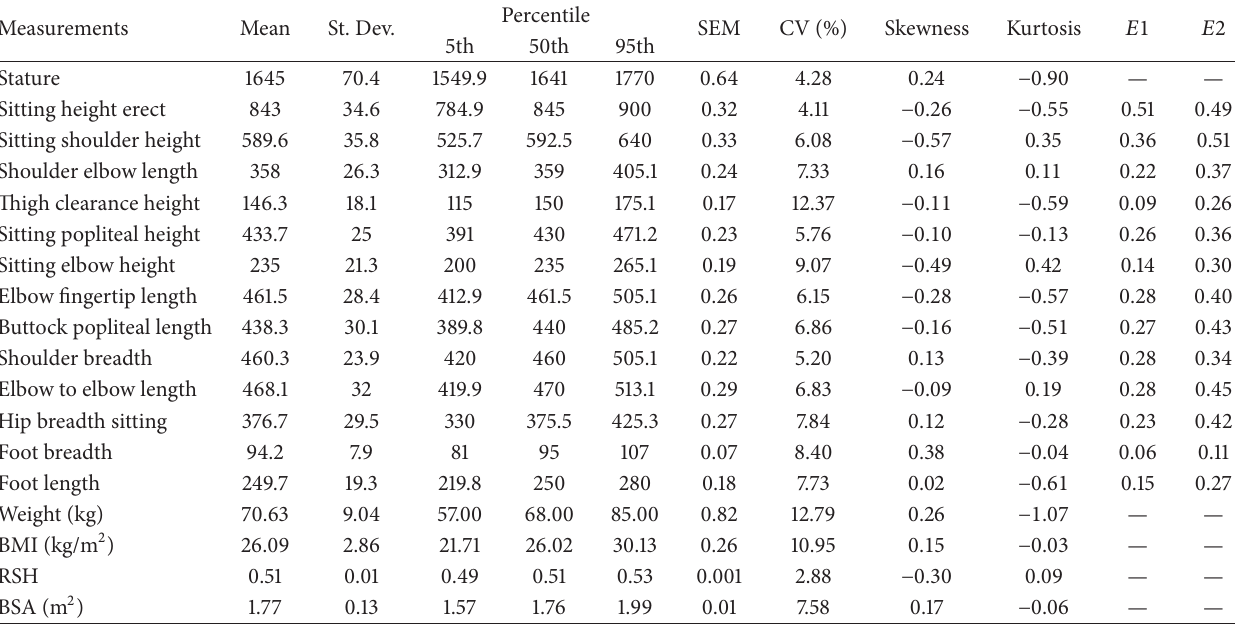
Table 1: Anthropometric dimensions of Bangladeshi vehicle